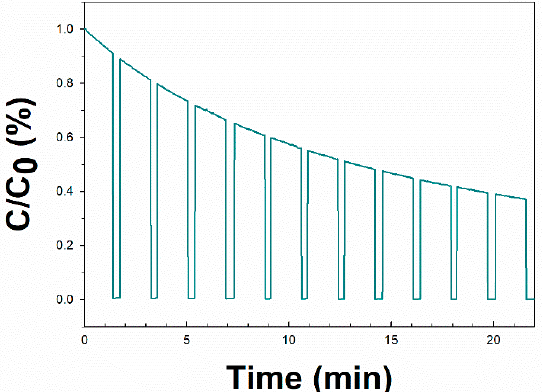
Figure 5. Particle number concentration graph by time. X-axis: time (min); Y-axis: the number proportion compared to the initial total concentration (C/C 0 ).